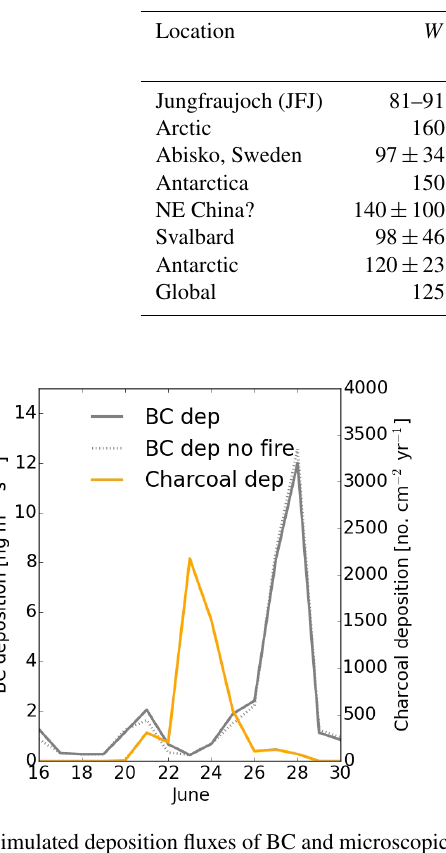
Figure 5. Simulated deposition fluxes of BC and microscopic char- coal at Jungfraujoch. In line with the observations, the deposition (dep) fluxes for BC are given as mass fluxes, whereas the deposition fluxes of microscopic charcoal are given as the flux of the number of particles larger than a certain threshold (10µm major axis). For BC, a simulation without fire emissions (dotted grey line) and a simu- lation including the fire emissions near Pedrógão Grande in central Portugal (solid grey line) are shown. For microscopic charcoal, only the simulation including fire emissions (solid orange line) is shown since biomass burning is the only source of microscopic